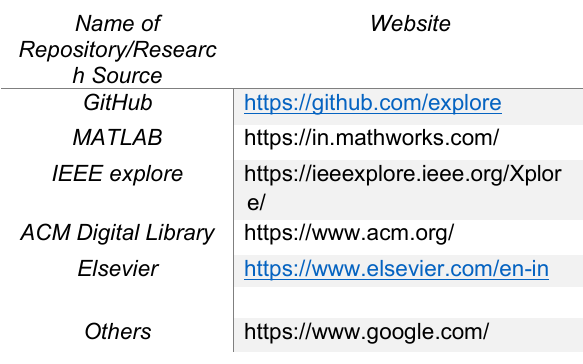
Table 1. Repositories/ Research Sources Explored for AOD method selection.